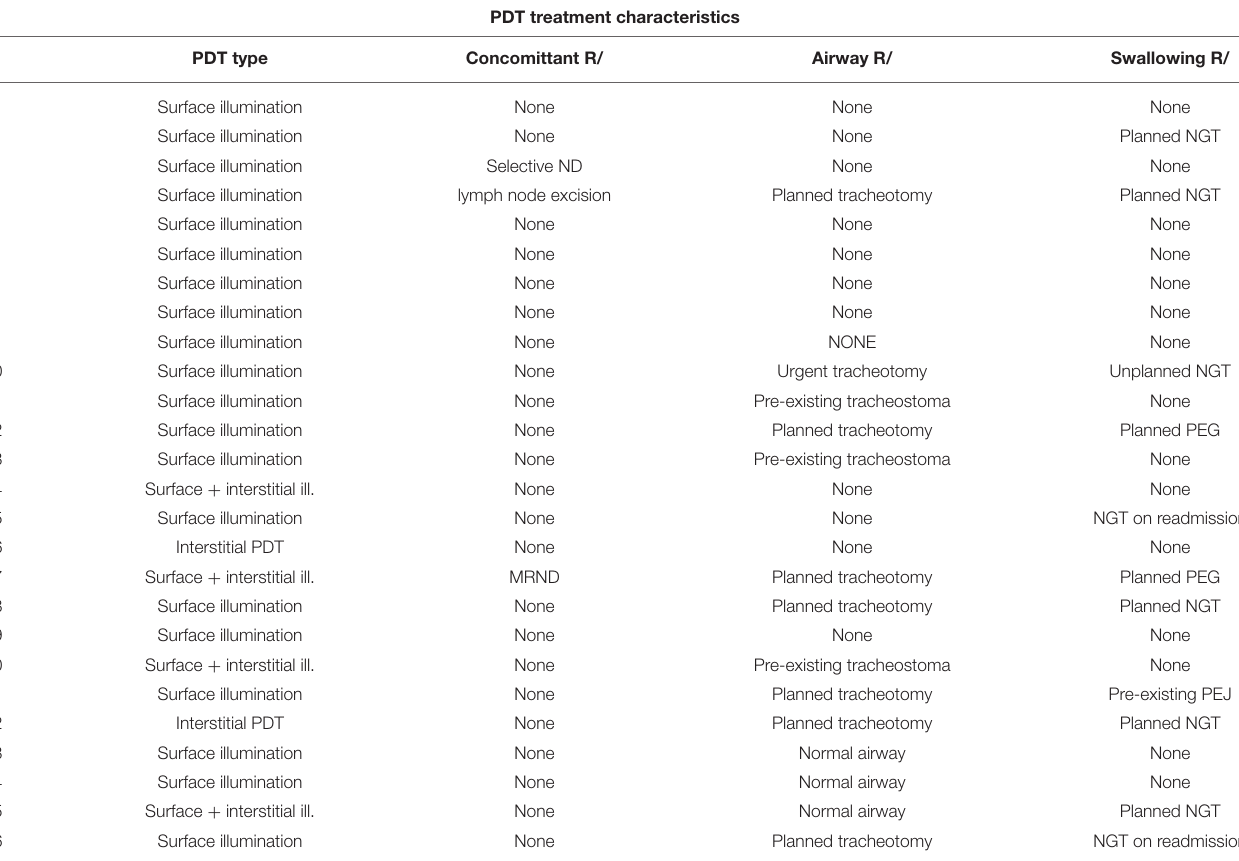
TABLE 5 | Photodynamic treatment type and associated interventions for 26 patients receiving therapy for cancer of the oral cavity or oropharynx with oral cavity extension. PDT treatment characteristics